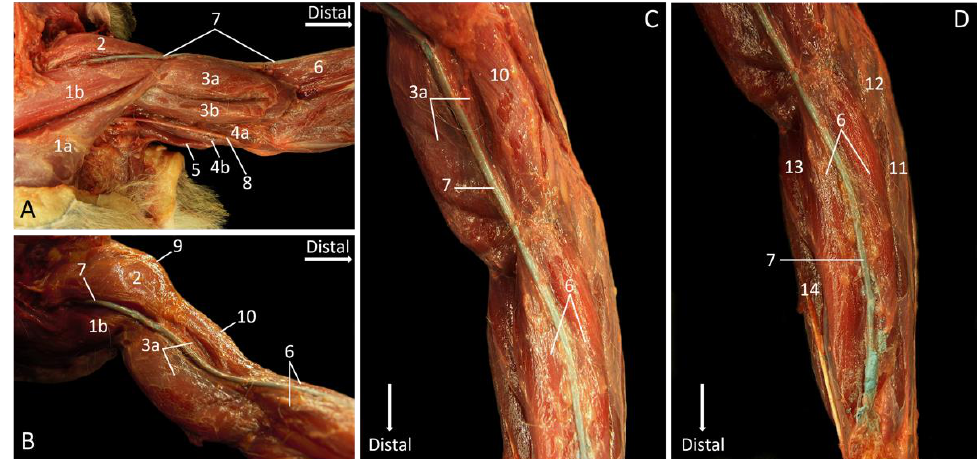
Figure 12. Trajectory of the left cephalic vein that was filled with blue latex. ( A ): shoulder region; ( B ): upper arm; ( C ): elbow region; ( D ): antebrachium.